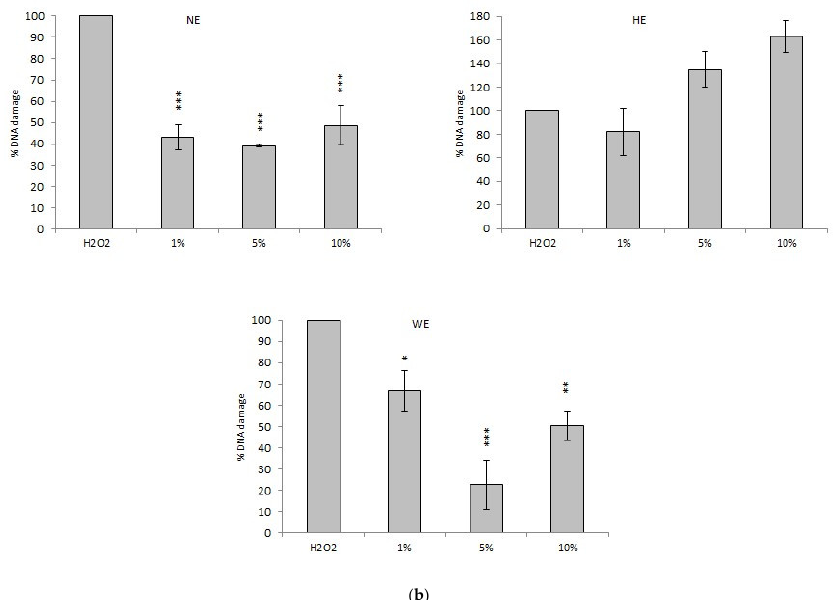
Figure 3. Percentage of reduction of DNA damage induced by H 2 O 2 after a 24 h pre-treatment with different concentration (* p < 0.05; ** p < 0.01; *** p < 0.001): ( a ) pure phytochemicals; ( b ) extracts. Among the antiproliferative phytochemicals, DNA damage reduction up to 40% was recorded with the highest dose of 20-hydroxyecdysone (1.5 and 15 µM) and, among the carotenoids, up to 50% with lutein 2 µM. β-carotene (1.5 and 15 µM) reduces DNA dam- age of about 15–20%. Despite its genotoxicity, also lutein 20 µM seems to induce a certain level of protection (~30%); the same level (~32%) observed after pre-treatment with the mixture of phytochemicals (Figure 3). Comet Assay with Spinach